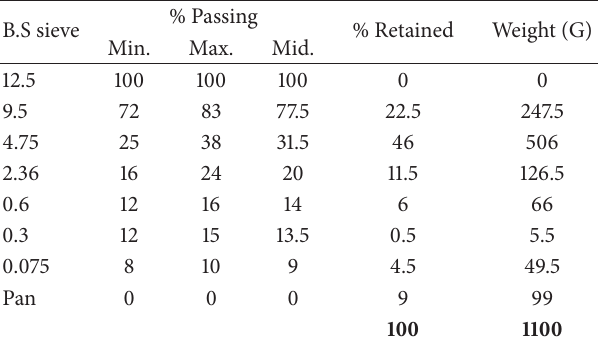
Table 4: SMA 14 aggregate gradation [20].